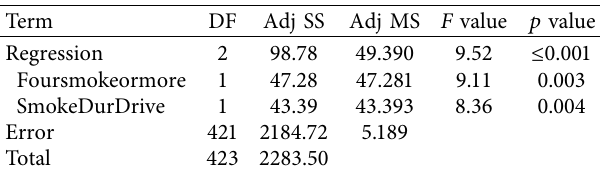
Figure 4: (a) Normal probability plot, (b) histogram of frequency versus residual of the new regression model, and (c) versus order plot. Table 5: Analysis of variance of AccidentFreq versus Four- smokeormore and